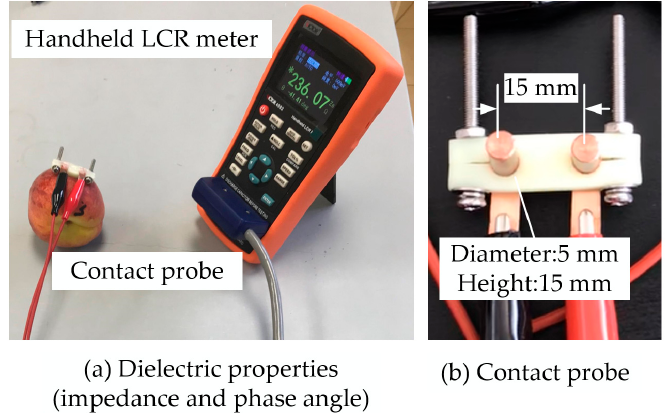
Figure 2. Contact probe and measurement of dielectric properties in peaches.